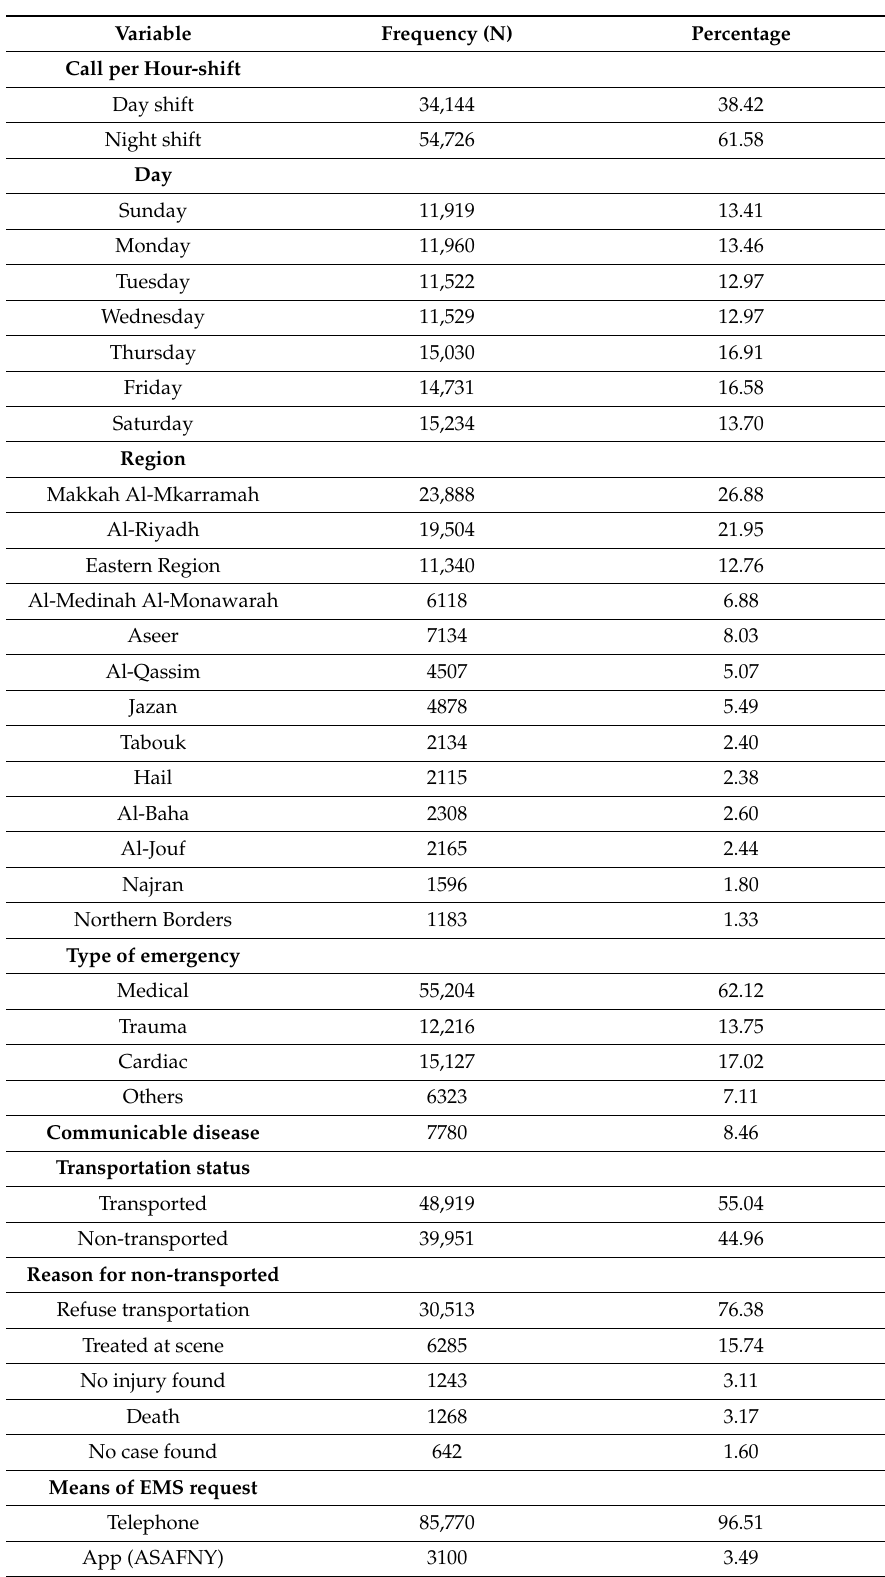
Table 3. Description of SRCS emergency calls (n = 88,870) in Saudi Arabia during Ramadan